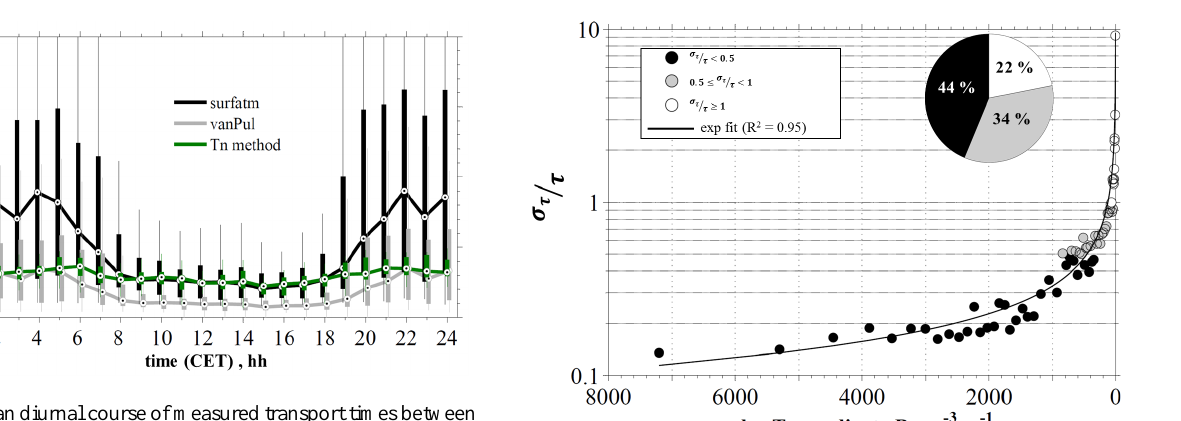
Fig. 10. Median diurnal course of measured transport times between 0.04 and 0.8m using the Tn method (values of inadequate quality were rejected) compared to existing empirical parameterizations for all data from block 3 for the natural grassland site. The statistical distribution of the data sets is represented by hourly boxplots. The dots indicate the medians, the filled boxes cover the interquartile range, and the whiskers represent the extreme data points.